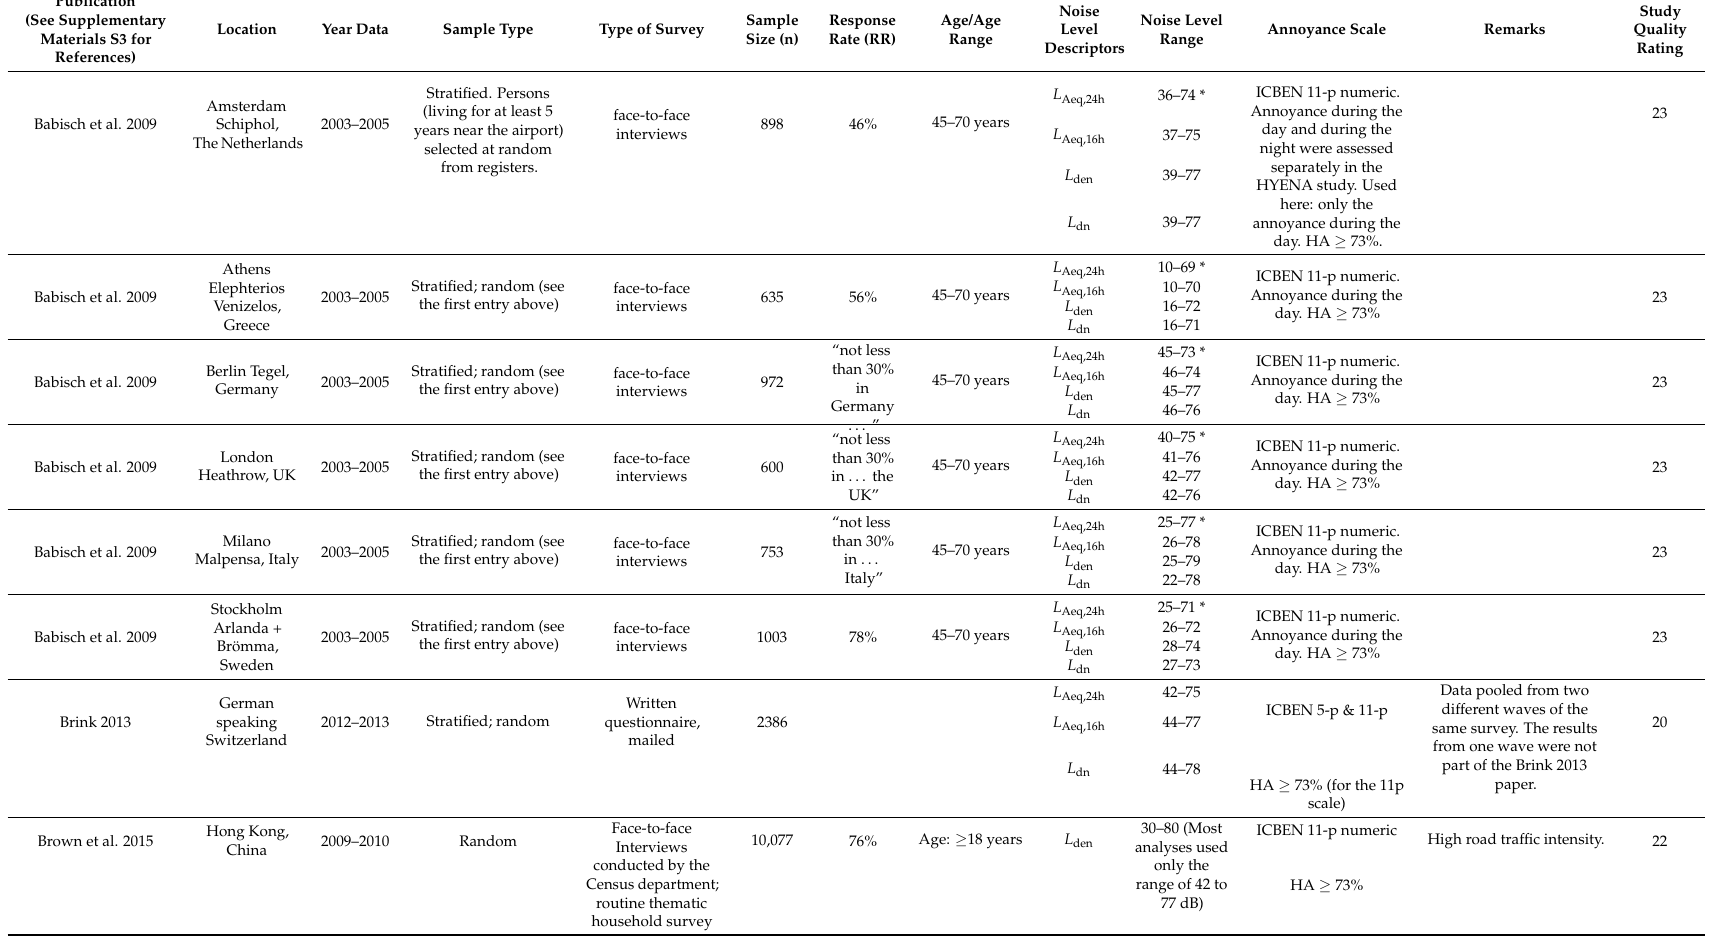
Table 3. Road traffic noise studies